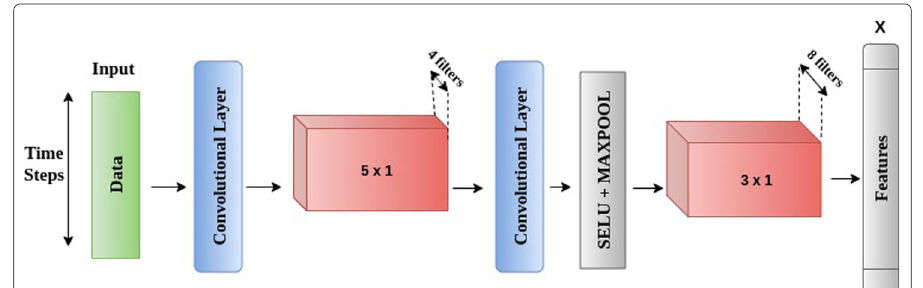
Fig. 1 Deep CTL architecture. The illustration is given for L = 2 layers, with the first layer T 1 composed of M 1 = 4 filters of size 5 × 1, and the second layer composed of M 2 = 8 filters of size 3 ×